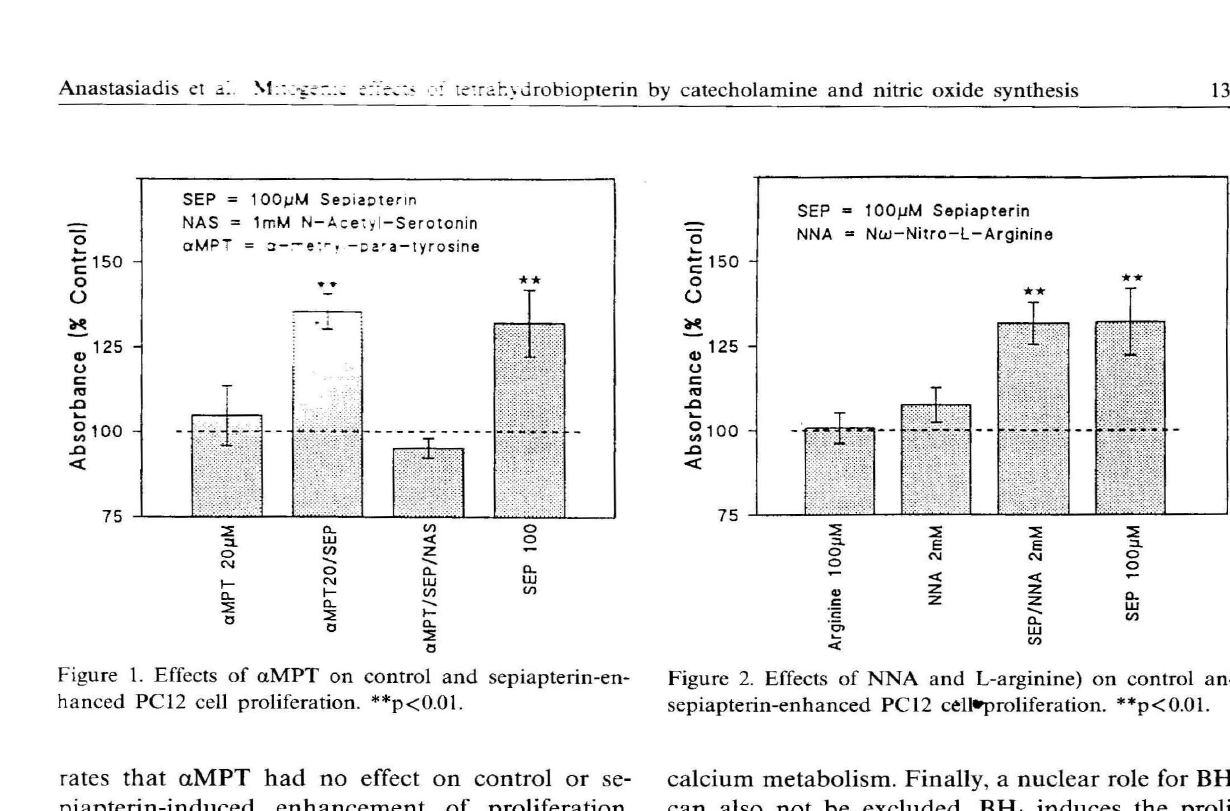
Figure 1. Effects of aMPT on control and sepiapterin-en hanced PC12 cell proliferation. **p<O.OI.